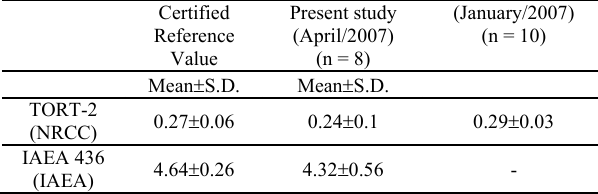
Table 1. Certified reference values and analyzed values for